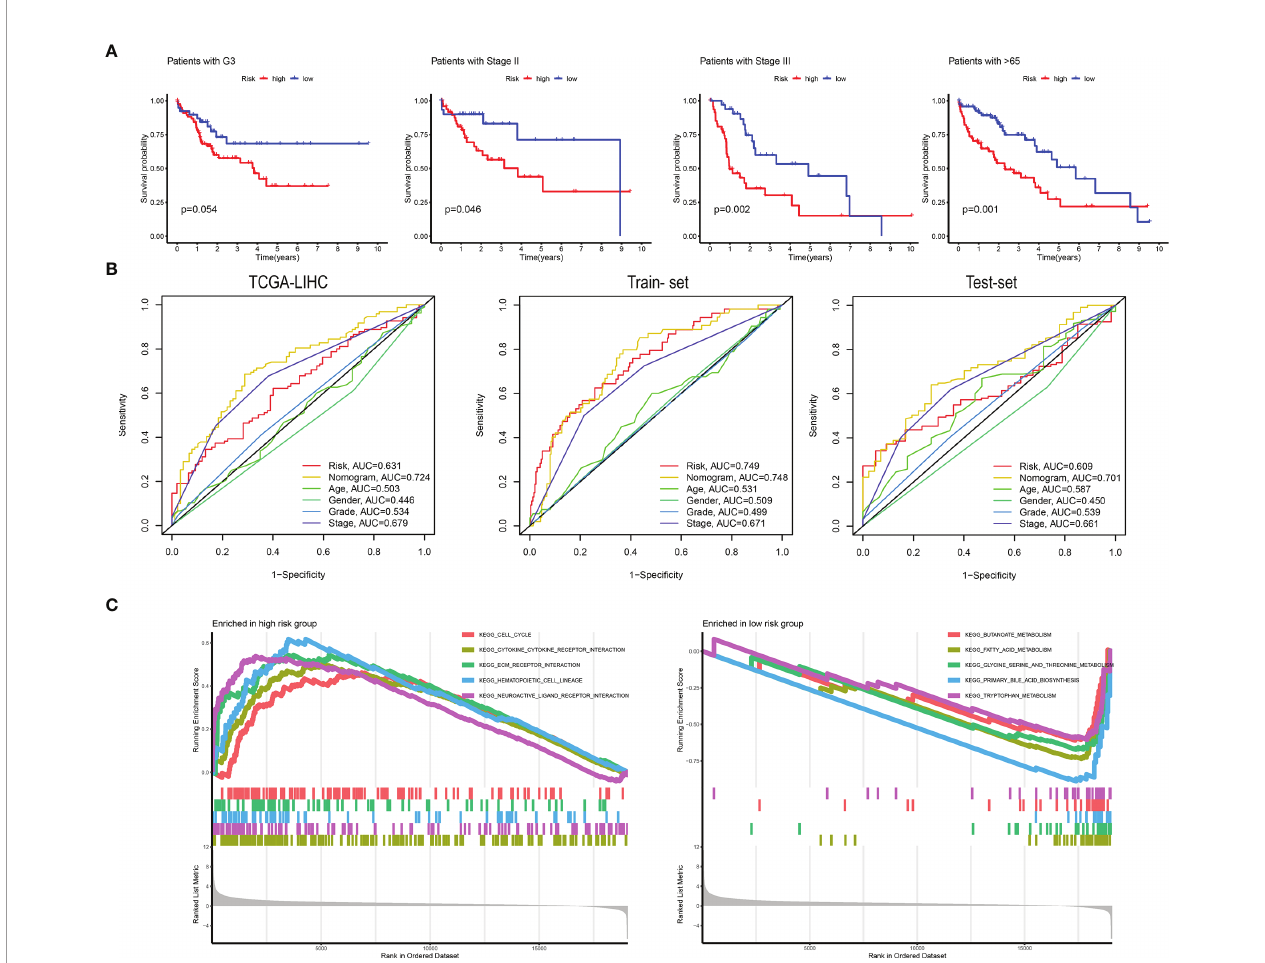
FIGURE 6 | (A) The high-risk and low-risk groups were divided according to G3, Stage II, Stage III, and 65 years. Survival curves were plotted. (B) ROC curves are grouped by risk, nomogram, age, sex, grade, and stage in TCGA-LIHC, training set, and validation set. (C) The main KEGG pathways are enriched in the high- and low-risk